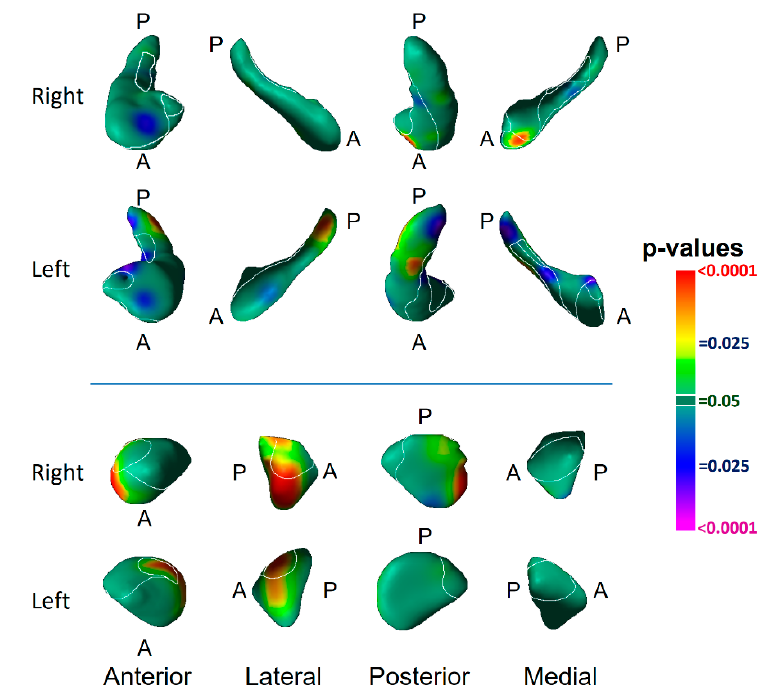
Figure 9. The Effects of Medication Use. Medication use at the time of MRI scanning was associated predominantly with inward deformations of the head, body, and tail of the hippocampus and of the lateral amygdala. None of the locations where we detected significant effects of medication were in locations where we detected significant effects of risk group or lifetime MDD, suggesting that our findings for risk group and lifetime MDD are likely independent of the effects of medication. We included only HR participants (N = 77) in this analysis, as only 6 LR participants were currently taking psychotropic medication. Covariates included age, age 2 , and sex. Findings were identical when including Lifetime MDD as a covariate. Of the 77 HR participants, 46 had lifetime MDD, 32 had no history of MDD, 20 were currently taking psychotropic medication, and 57 were not taking medication at the time of MRI scanning.